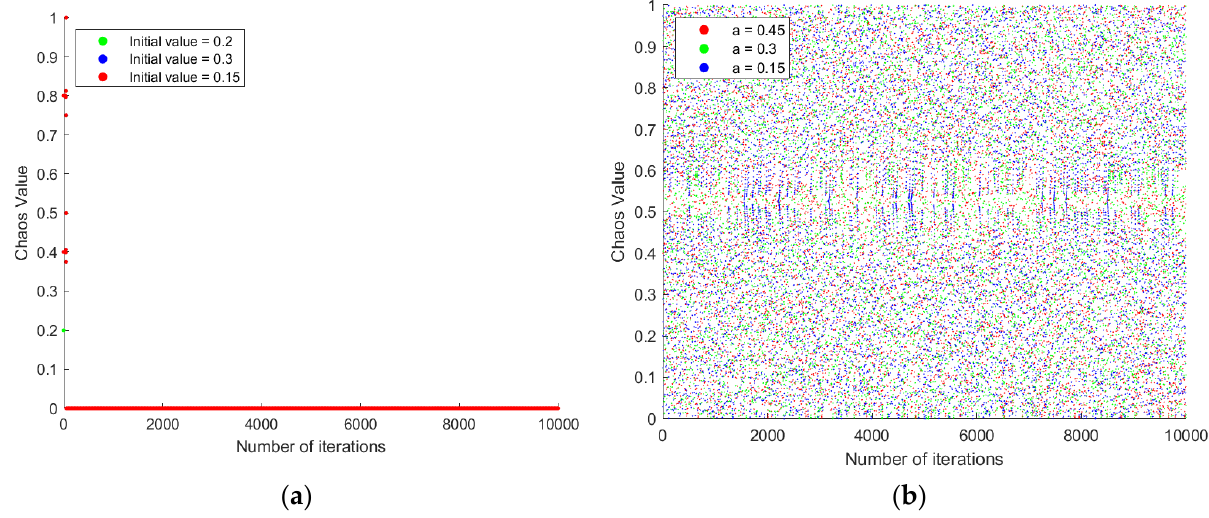
Figure 4. The small period nature of Tent chaotic mapping. ( a ) At a = 0.5 and initial values of 0.2, 0.4, and 0.8, the Tent chaotic mapping falls into a small loop, resulting in a sequence that is not chaotic in nature. ( b ) The random sequence generated by the Tent chaos mapping with a = 0.45 and initial values of 0.2, 0.3, and 0.15.